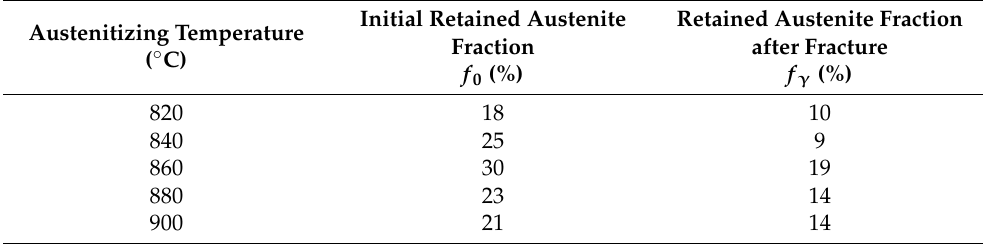
Table 5. Retained austenite fraction of the carburized specimens of the experimental steel during tensile test.